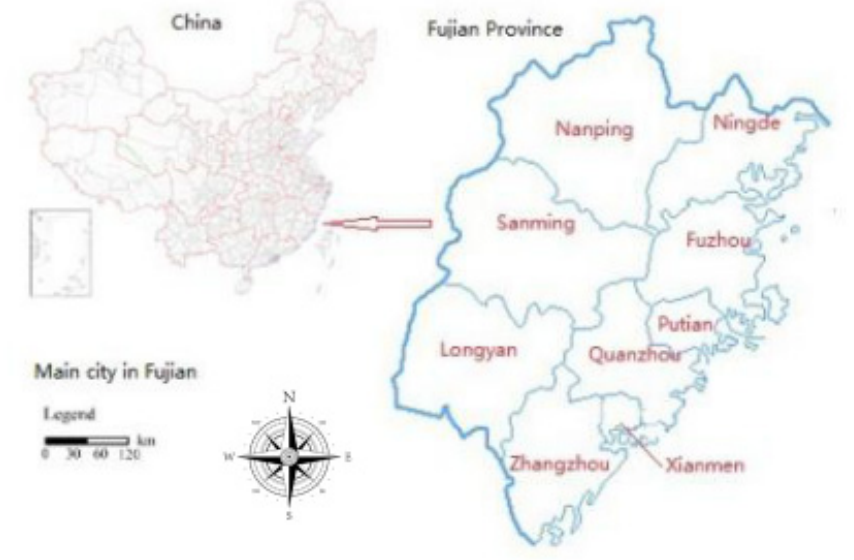
Figure 1. Location of study area and distribution of main cities.